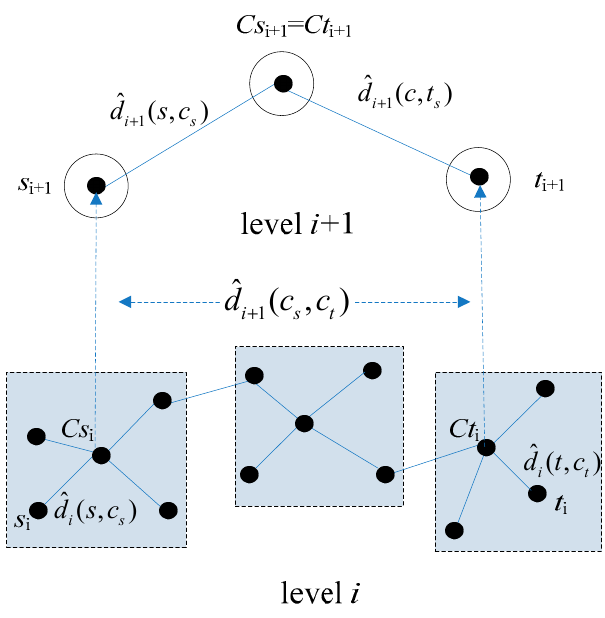
Figure 2. Illustration of iterative approximation.